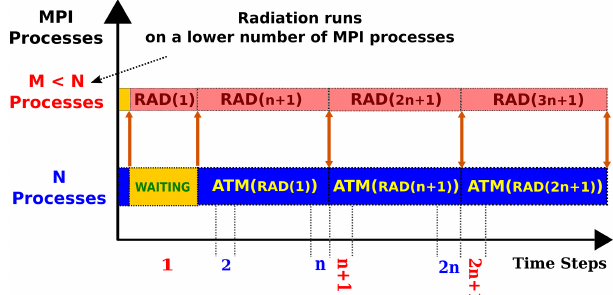
Figure 12. A model configuration for assigning identical domain decomposition to the radiation component and the main model but reducing the radiation time step to half ( (cid:49)t rad = n/ 2 × (cid:49)t atm ), hence improving the parallel efficiency of the model.